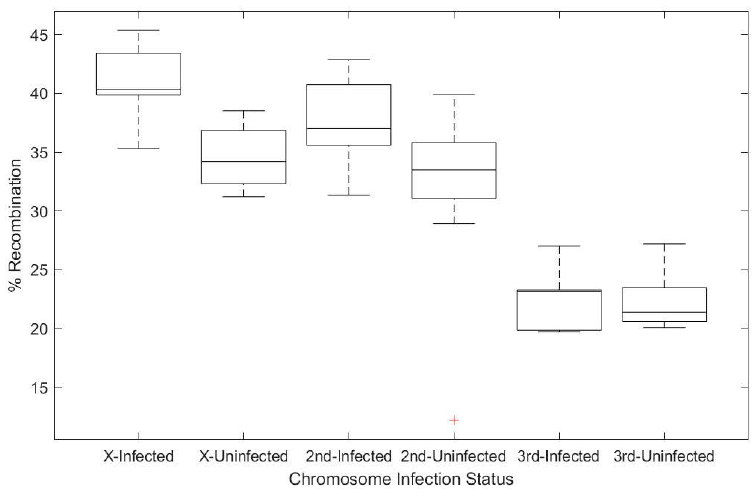
Figure 2. Box and whisker plots showing percentage of recombinants observed, based on genetic markers on the X, 2nd, and 3rd chromosome of Drosophila . Wolbachia infection significantly increased the recombination rate observed on both the X and 2nd chromosome by 6.4 and 6.1%, respectively. A significant increase was observed for the X (df = 1, χ 2 = 14.316, p < 0.001) and the 2nd chromosome (df = 1, χ 2 = 5.597, p = 0.018), but not on the 3rd chromosome (df = 1, χ 2 = 2.156, p = 0.142). Uninfected = DGRP-83; Infected = DGRP-320.